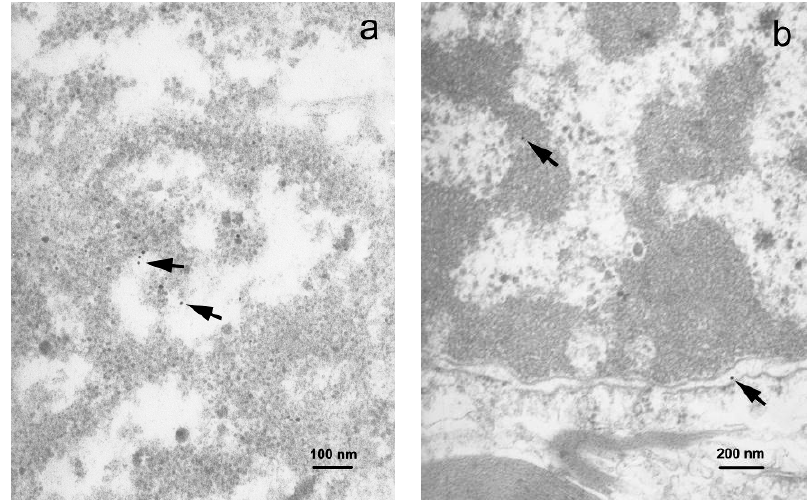
Figure 5. Immunogold staining, TEM: ( a ) Immunolabeled neuronal soma demonstrating the presence of the viral proteins in the nucleus (small dots showed by arrows, 50,000×); ( b ) (small dots showed by arrows, 30,000×). Nuclei show electron dense (dark) heterochromatin and electron lucid (light) euchromatin enclosed by nuclear envelope.